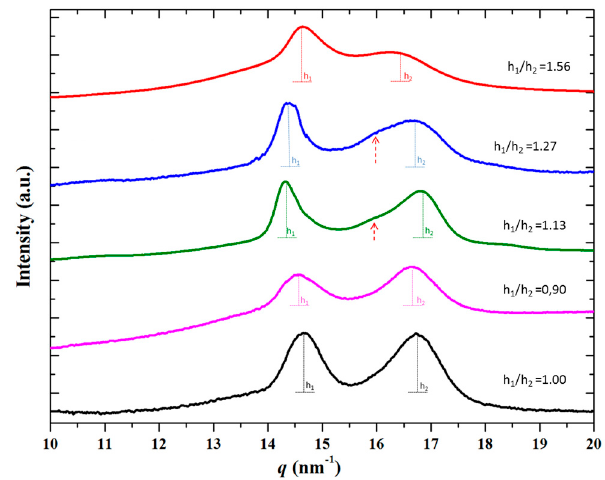
Figure 12. Diffraction profiles of nylon 4 9 samples taken at room temperature from down to up: as synthesized sample, solvent casting film from HFIP at a polymer concentration of 2 mg/mL, solvent casting film from formic acid at a polymer concentration of 2 mg/mL, solvent casting film from formic acid at a polymer concentration of 10 mg/mL and a melt quenched sample.